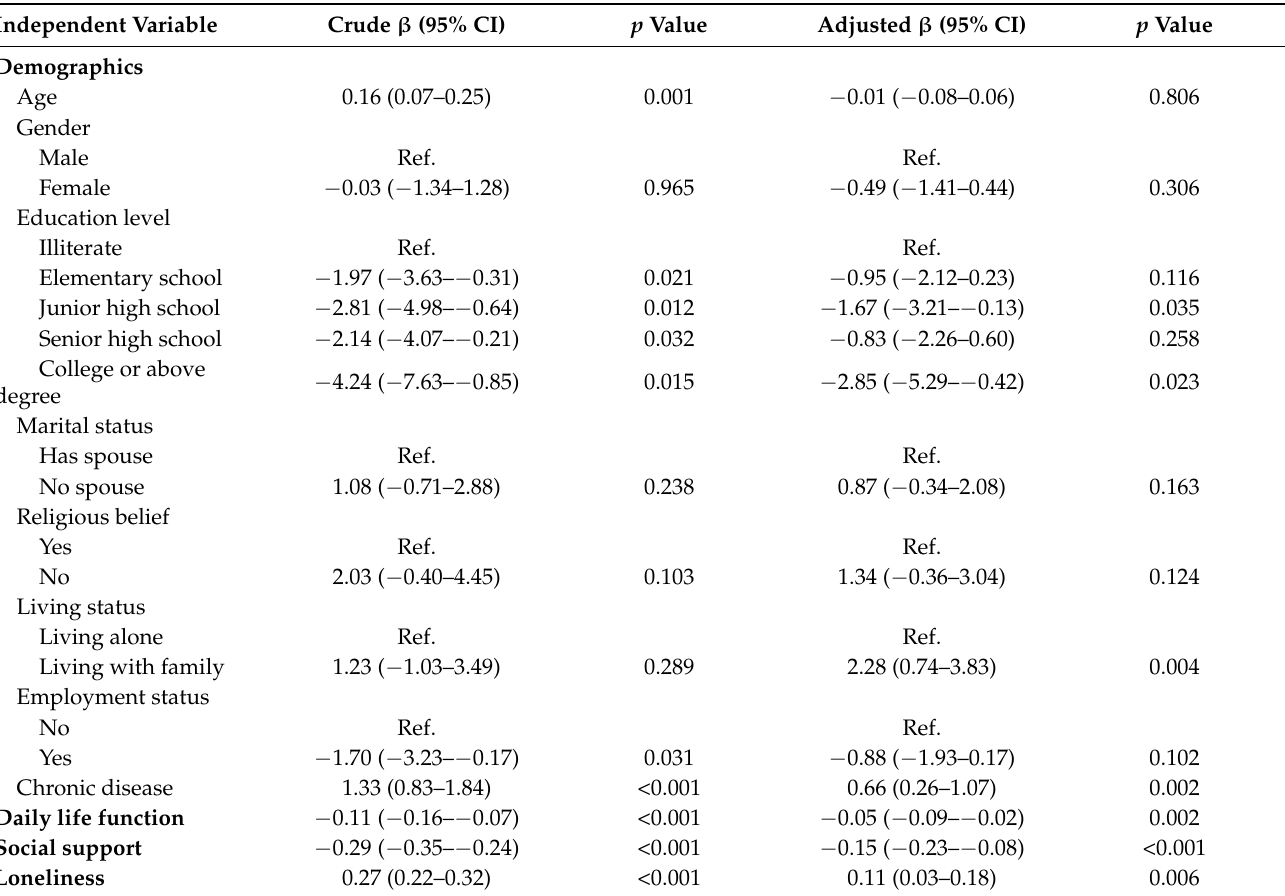
Table 3. Predictors of depression level in community-dwelling elderly persons ( N =